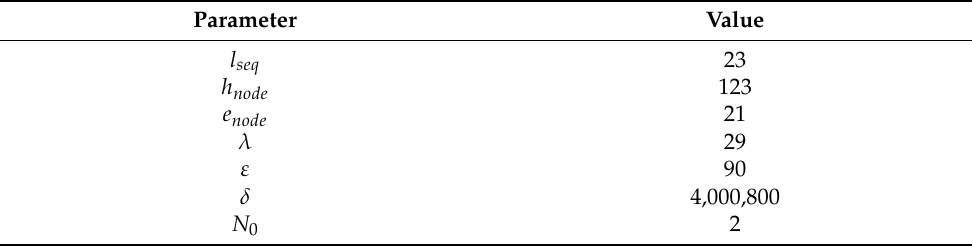
Table 1. Parameters of S-LSTM